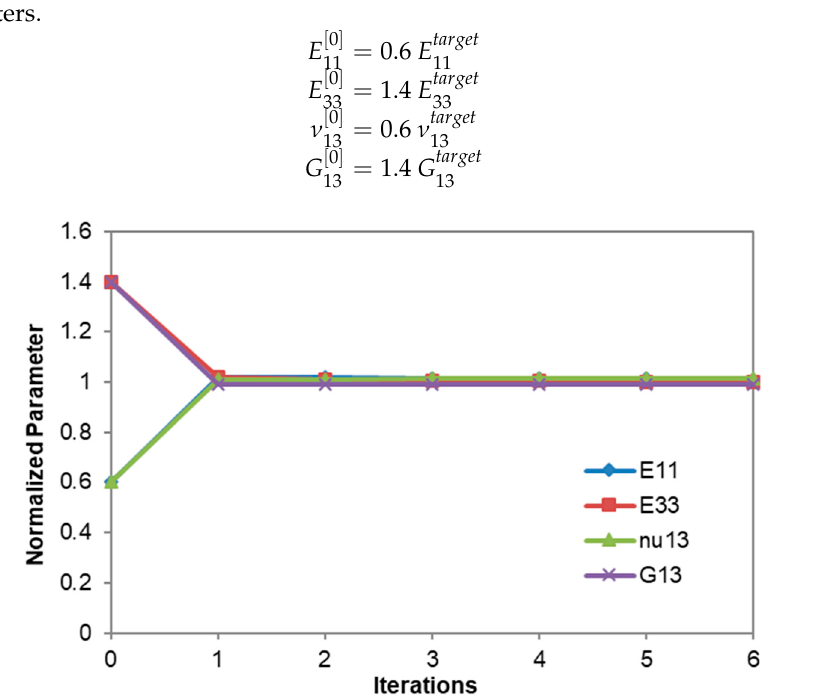
Figure 9. Convergence of normalized material parameters to their target value.